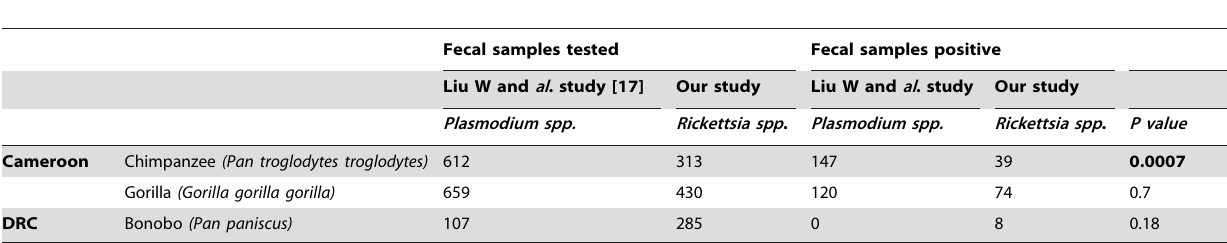
Table 2. Prevalence of Plasmodium spp. [17] and Rickettsia spp. in chimpanzees, gorillas and bonobos found in Cameroon and